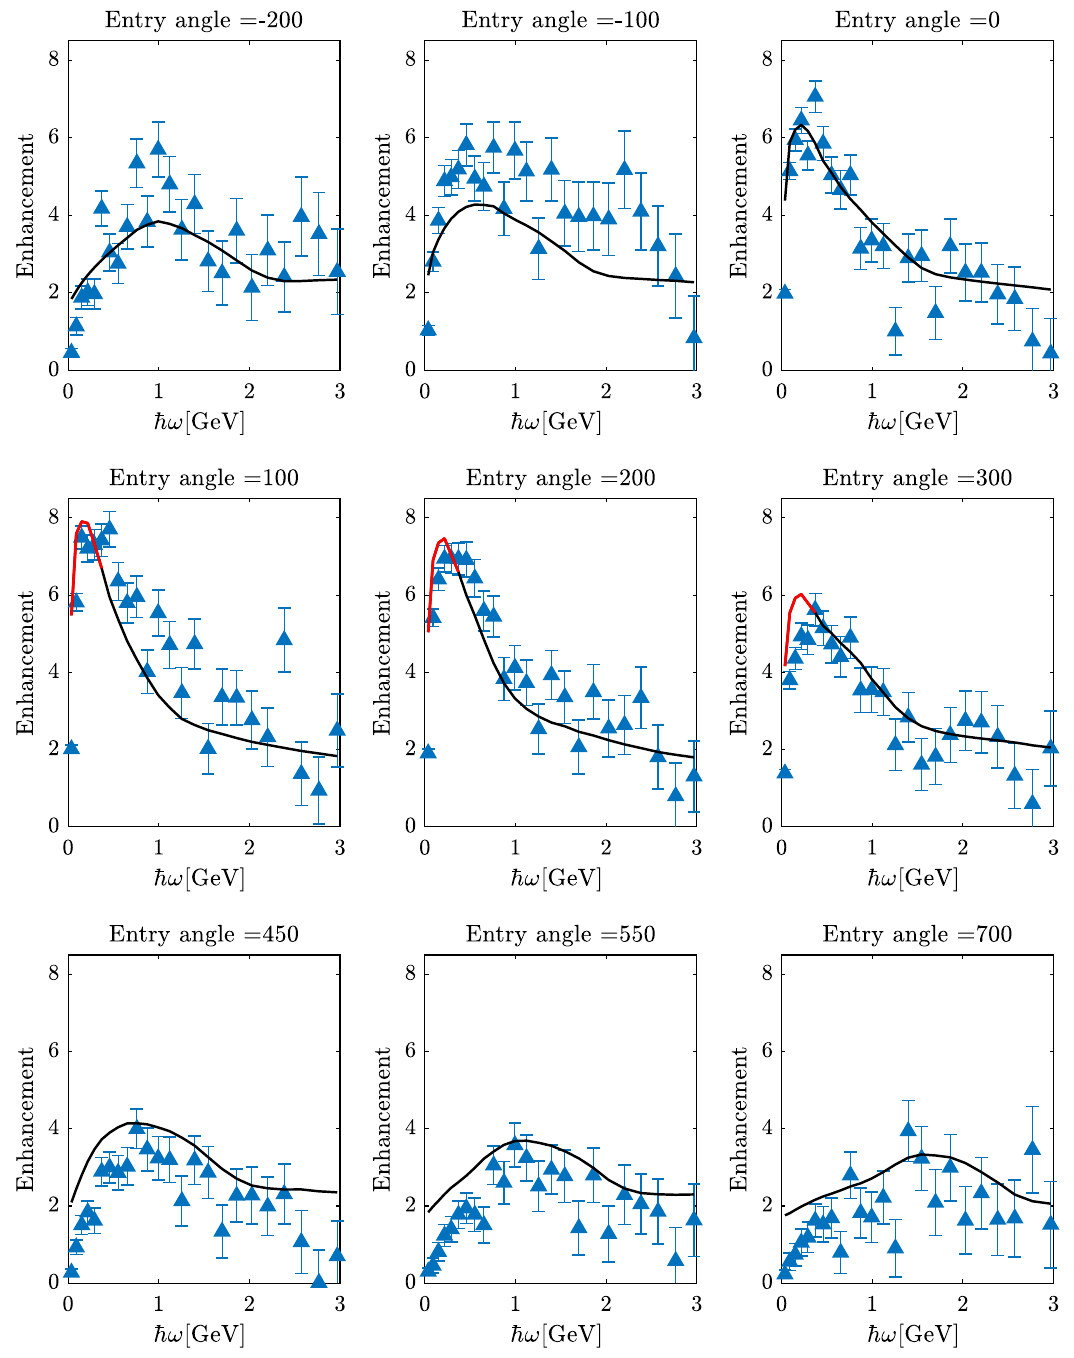
FIG. 7. Radiation spectra from 12.6 GeV electrons with different entry angles with respect to the (111) plane of a 60 μ m thick bent silicon crystal. The blue data points are the experimental data points and the black curves show the results of the theoretical simulation which has no free parameters. The red curve highlights the area of the spectrum which is dominated by VR as seen from Figs. 4 and